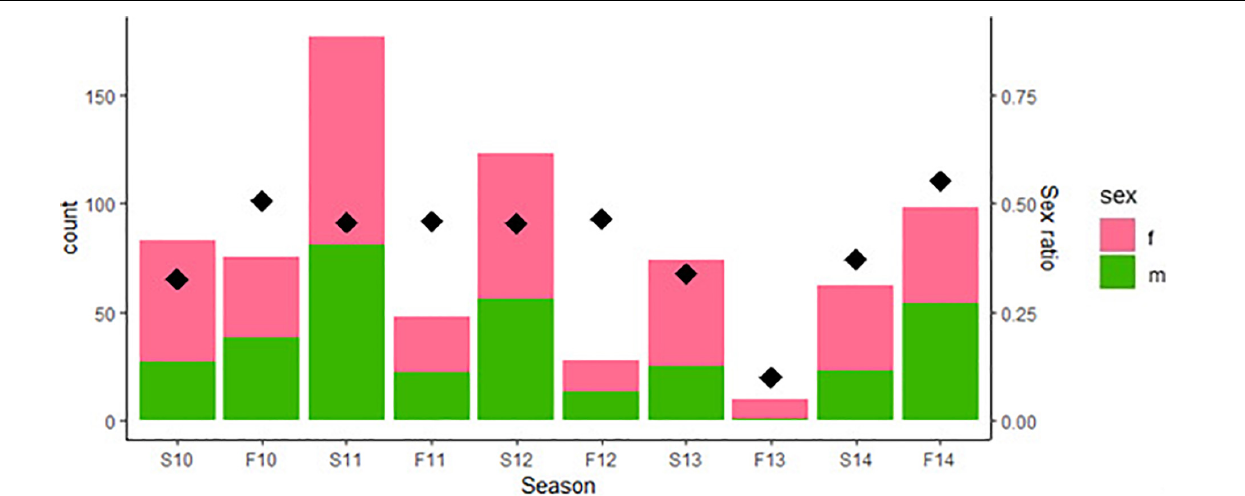
FIGURE 1 | Counts of adult male and adult female green anole lizards in the Washington Square Park population from 2010 to 2014 broken down by census period [i.e., by spring (S) and Fall (F) of each year]. Thus “S10” denotes the spring of 2010, “F10” the fall of 2010, and so on. Diamonds represent the sex ratio, calculated as proportion of males among all adults in the population as indicated on the right axis, for each census period.